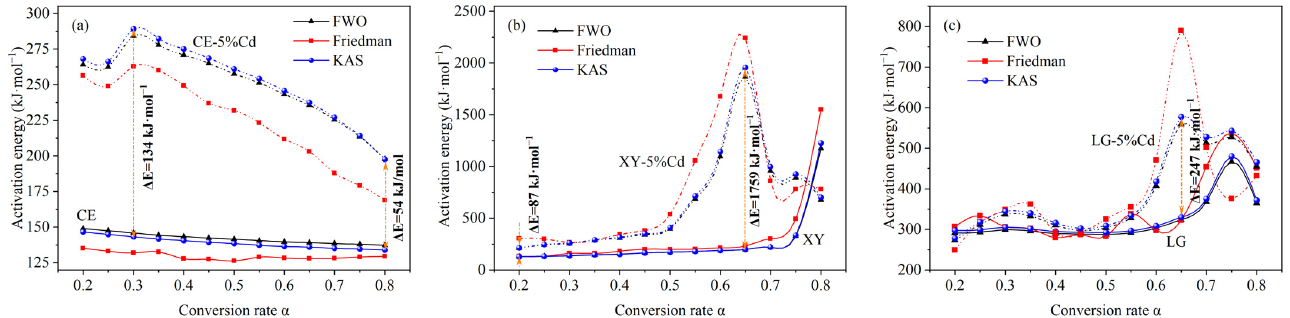
Figure 3. APAE distribution of three model components at the different conversion rates. ( a ) CE and CE-5%Cd; ( b ) XY and XY-5%Cd; ( c ) LG and LG-5%Cd. The solid line and dotted line represent the control group and Cd-concentrated samples, respectively.